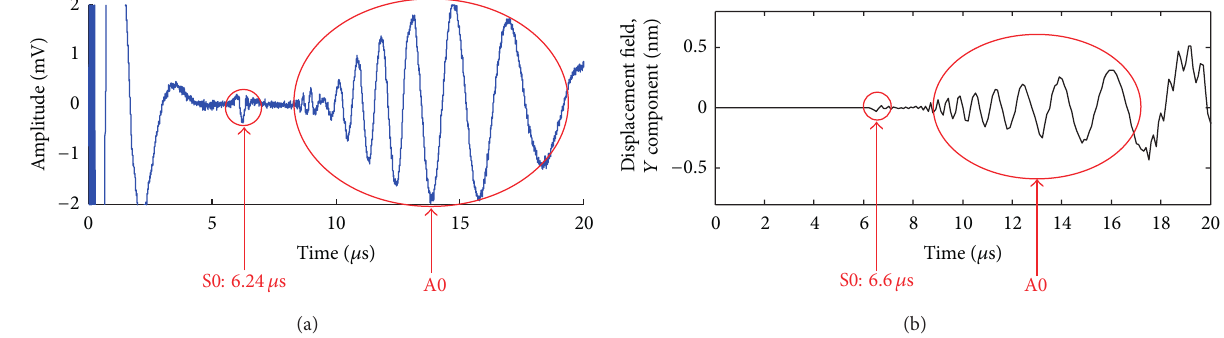
Figure 6: (a) Experimental result and (b) simulation result for mode identification.